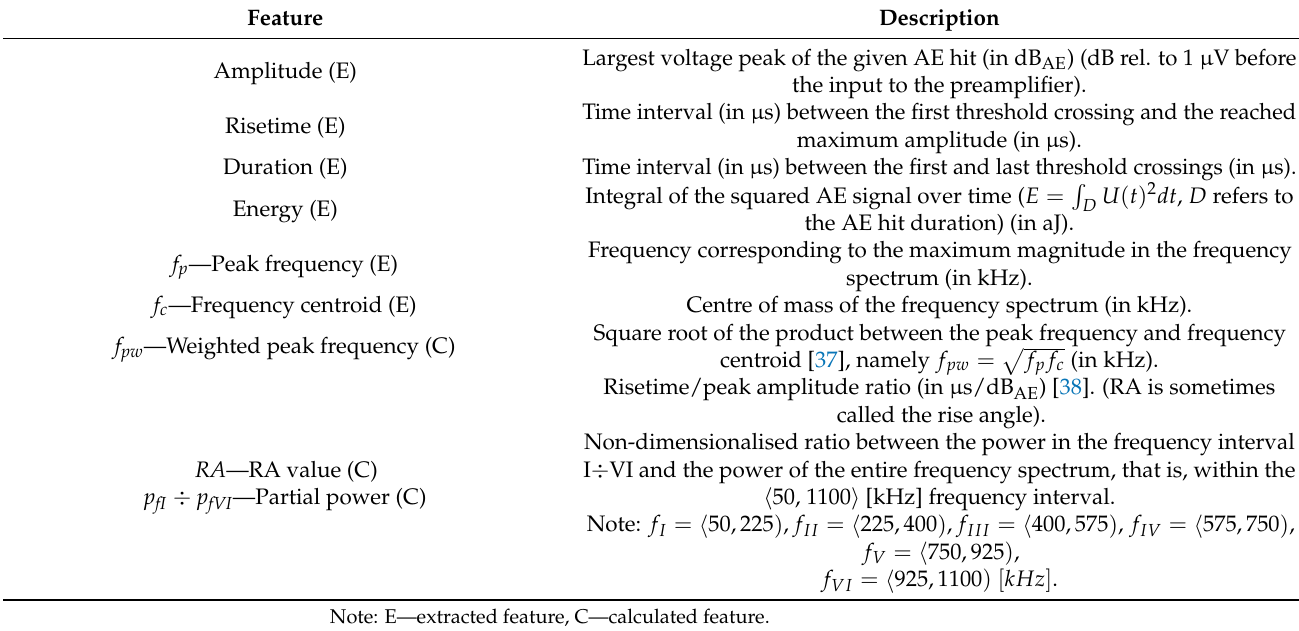
Table 4. Characterisation of AE features used in this